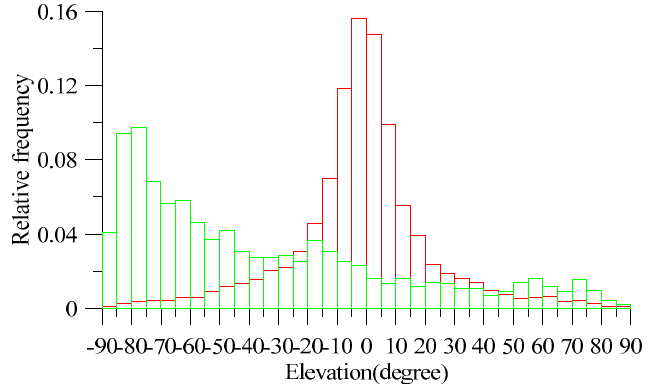
Figure 2. Elevation distributions for wave vector ( green ) and group velocity ( red ).